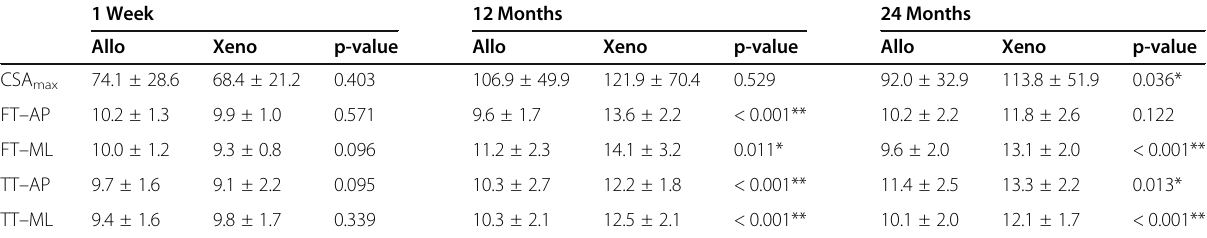
Table 6 MRI Evaluation (Cross-Sectional Area and Tunnel Dimensions) - Missing/Contaminated Graft Subjects Excluded